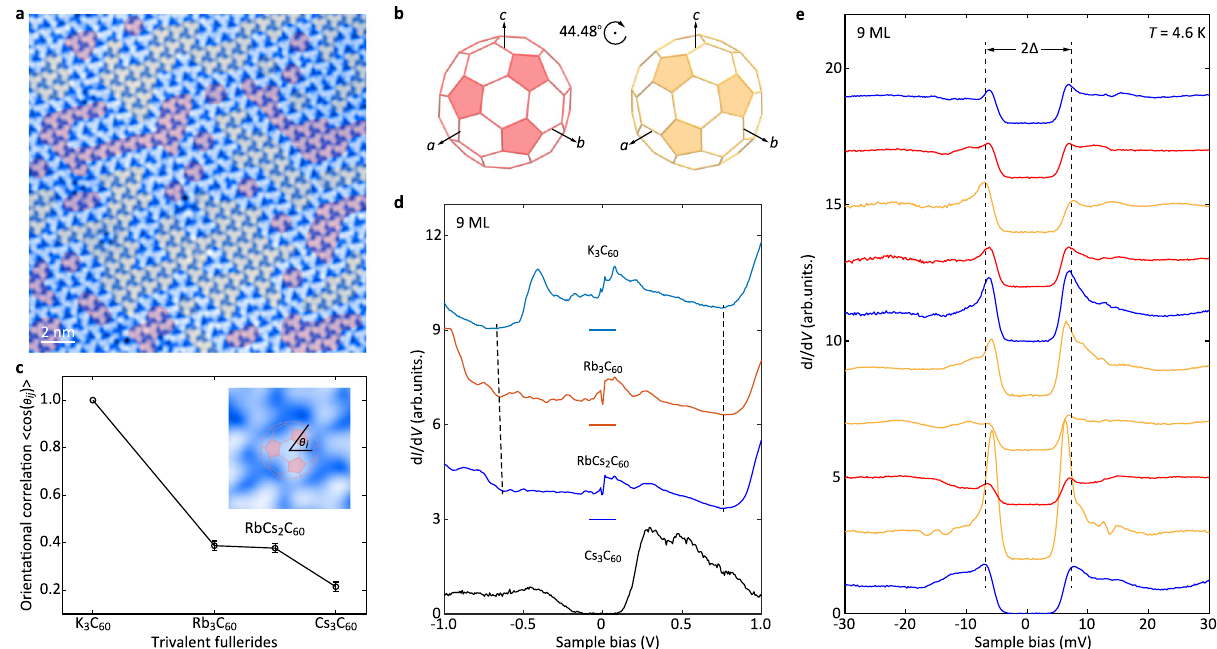
Fig. 1 Merohedral disorder and superconductivity in Rb 3 C 60 . a Scanning tunneling microscopy (STM) topography (20 nm × 20 nm, V = 1.0 V, I = 30 pA) on nine monolayer (ML) Rb 3 C 60 fi lms. The V and I represent the applied sample bias and tunneling current, respectively. Two standard orientations of C 60 related by 44.48 o rotation about the [111] axis are partially opaci fi ed in red and orange, respectively. b Schematic view of the two standard orientations of C 60 molecules along the [111] direction. c Alkali metal ion dependence of the orientational correlation of C 60 molecules (i.e., merohedral disorder). The statistical errors indicate the standard derivations of the merohedral disorder measured in various regions. Inset: de fi nition of the angle θ i of C 60 orientation with respect to the horizontal axis. d Spatially averaged differential conductance d I /d V spectra on 9 ML A 3 C 60 ( A = K, Rb, Cs) fi lms. The spectra have been vertically offset for clarity, with their zero conductance positions marked by correspondingly colored horizontal lines. Setpoint: V = 1.0 V and I = 200 pA. e Conductance d I /d V spectra ( V = 30 mV and I = 200 pA) taken at equal separation (2.8 nm) along the diagonal line from top left to the bottom right and color-coded to match the C 60 domains in a